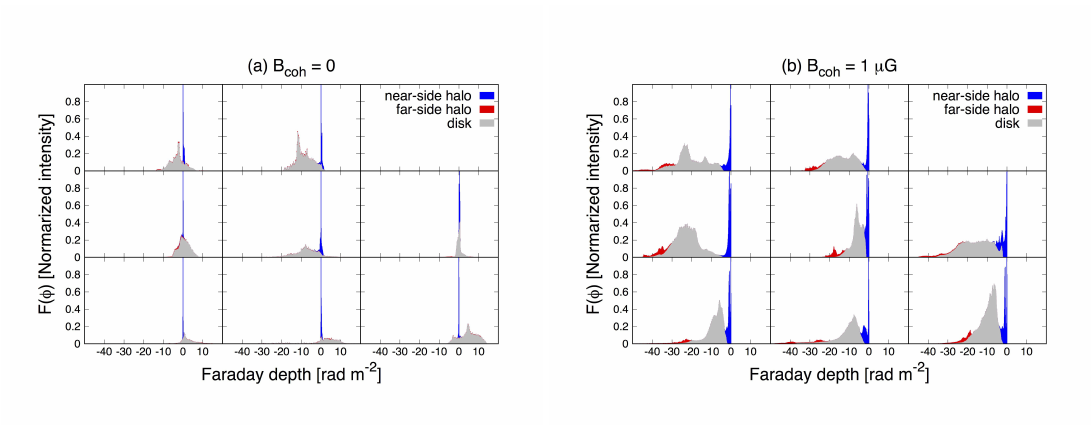
Figure 2. ( a ) Faraday spectra, F ( φ ) , for the “ B coh = 0” case ( left panels) and for the “ B coh = 1 µ G” case ( right panels). These are integrated F ( φ ) over all LOSs (32 × 32 LOSs). In each case, eight different realizations are shown. Colors in each panel show the contributions from the near-side halo (blue), disk (gray), and far-side halo (red) along the